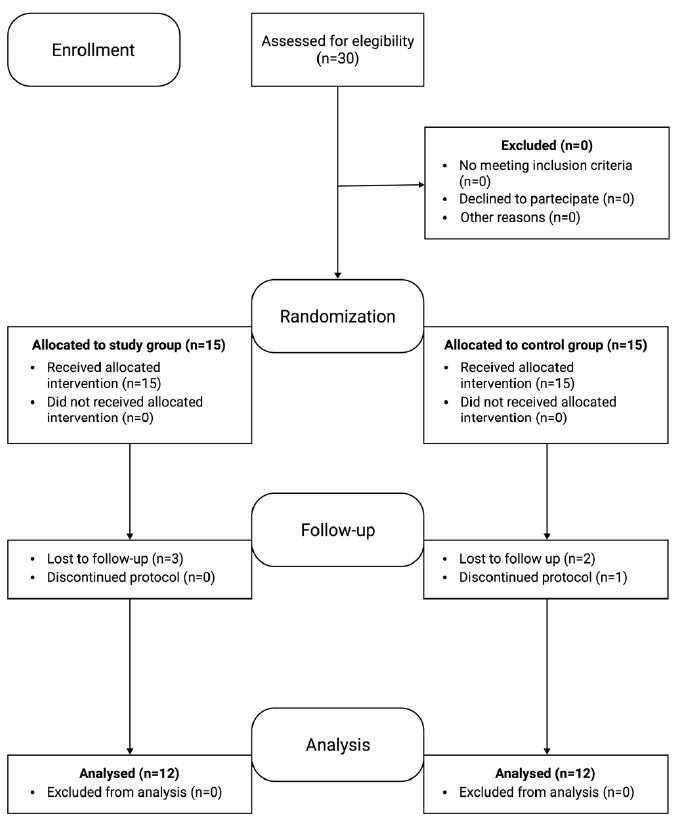
Figure 1. Flow-chart of the study enrollment.